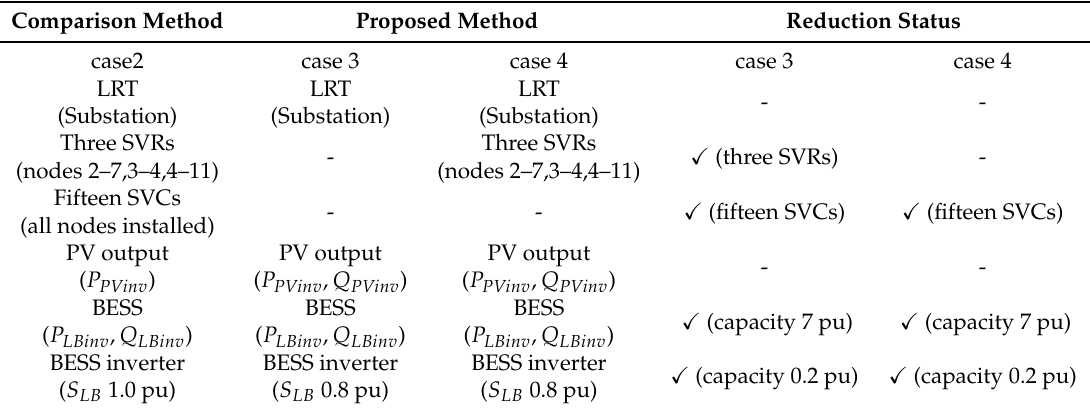
Table 3. Control device cases and reduction state for each